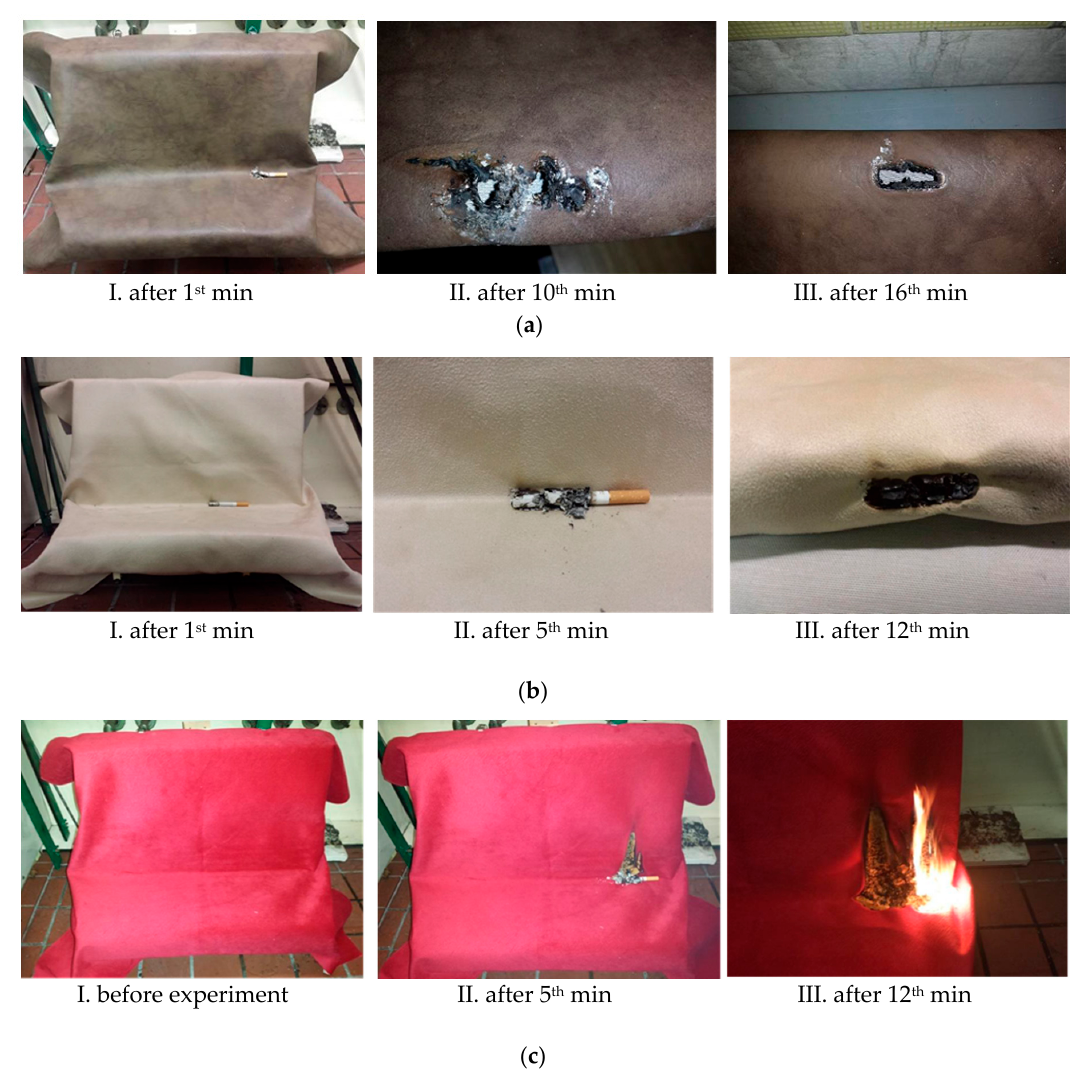
Figure 3. The experiment using a burning cigarette on ( a ) Sample 1, ( b ) Sample 2, and ( c ) Sample 3.